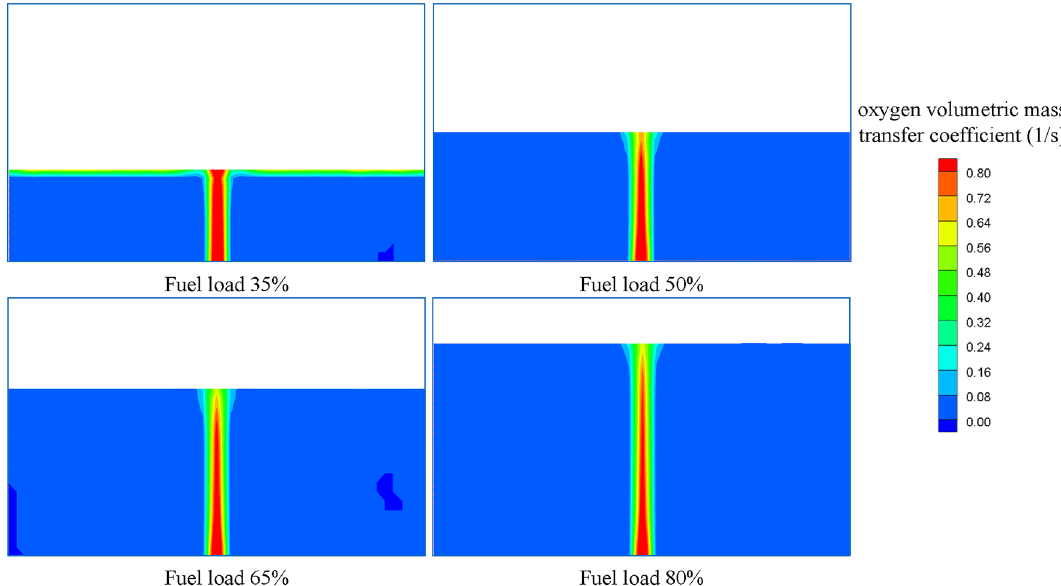
Figure 14. Oxygen volumetric mass transfer coefficients at different fuel